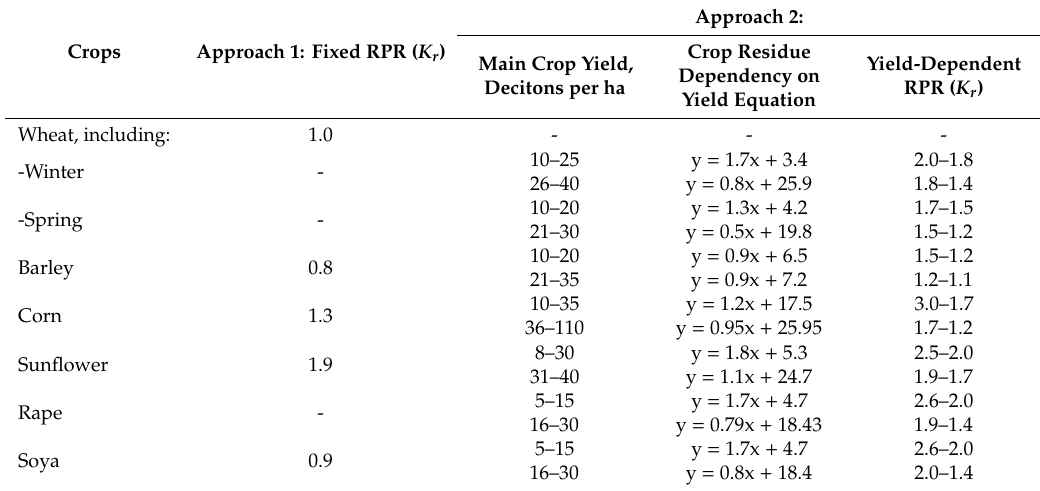
Table 1. RPRs (fixed and yield-dependent) for selected